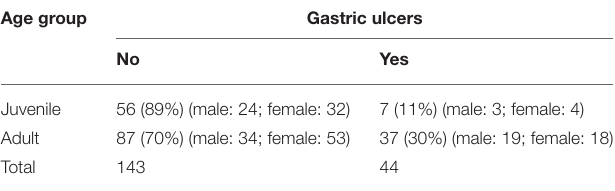
TABLE 1 | Incidence of gastric ulcers in juvenile and adult alpacas ( n = 187). Age